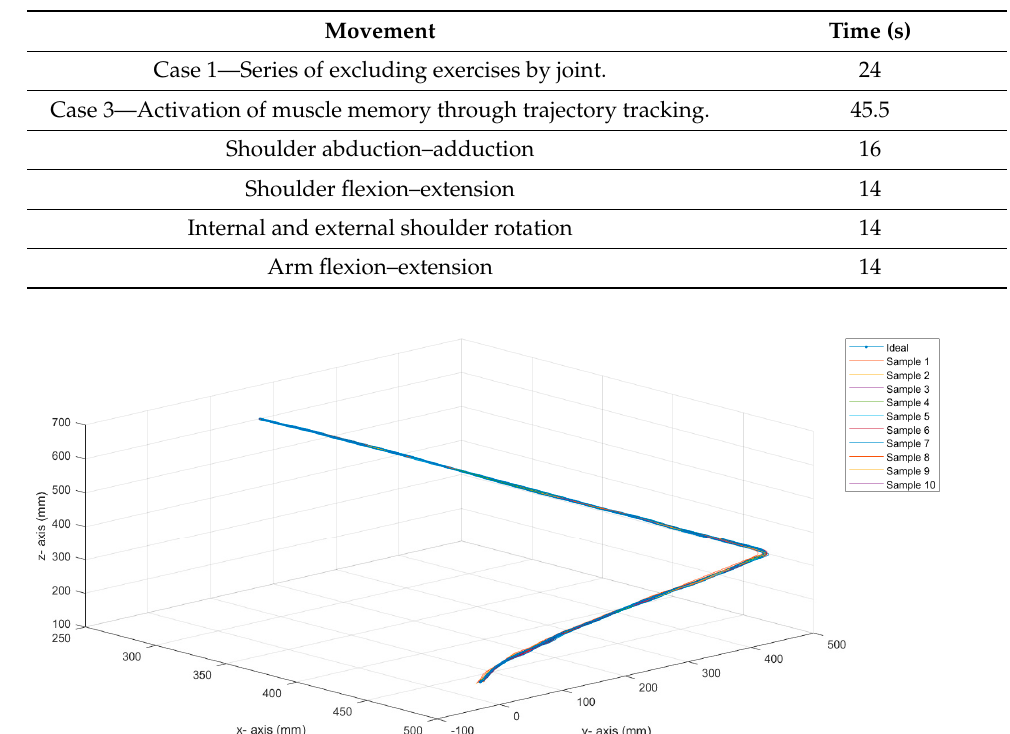
Figure 6. Trajectories of case 3-Activation of muscle memory through trajectory tracking.